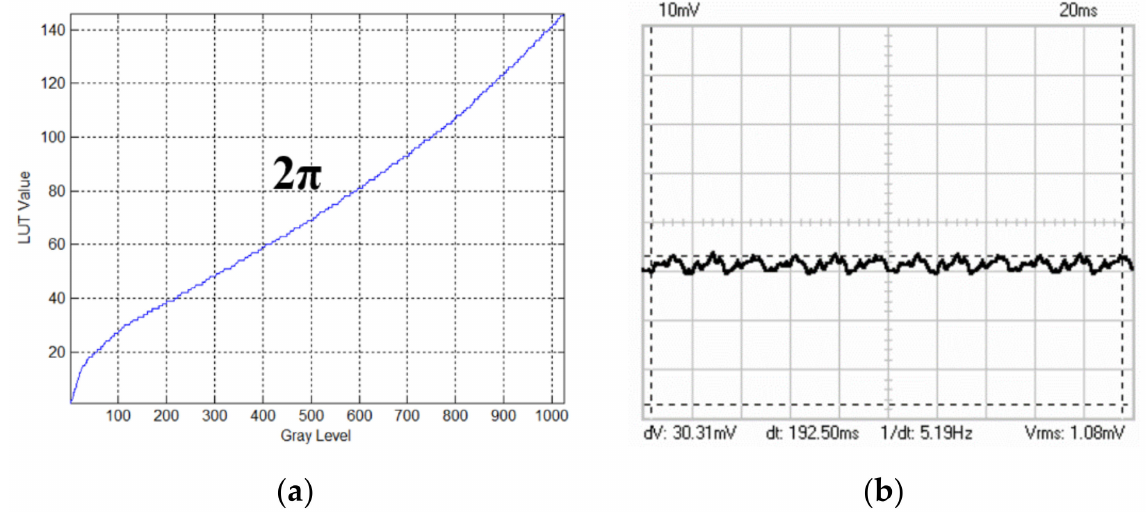
Figure 8. ( a ) LUT table encoded from 191 to 146 values to get 2 π phase modulation. ( b ) Typical flicker of 5-5 configuration. After these preprocessing steps, the LCoS-SLM could be applied with the Twyman- Green interferometer to generate the test kinoform patterns and get the phase response for each gray level. The schematic diagram of the experiment is shown as Figure 9. The details of it are discussed in the following sections.